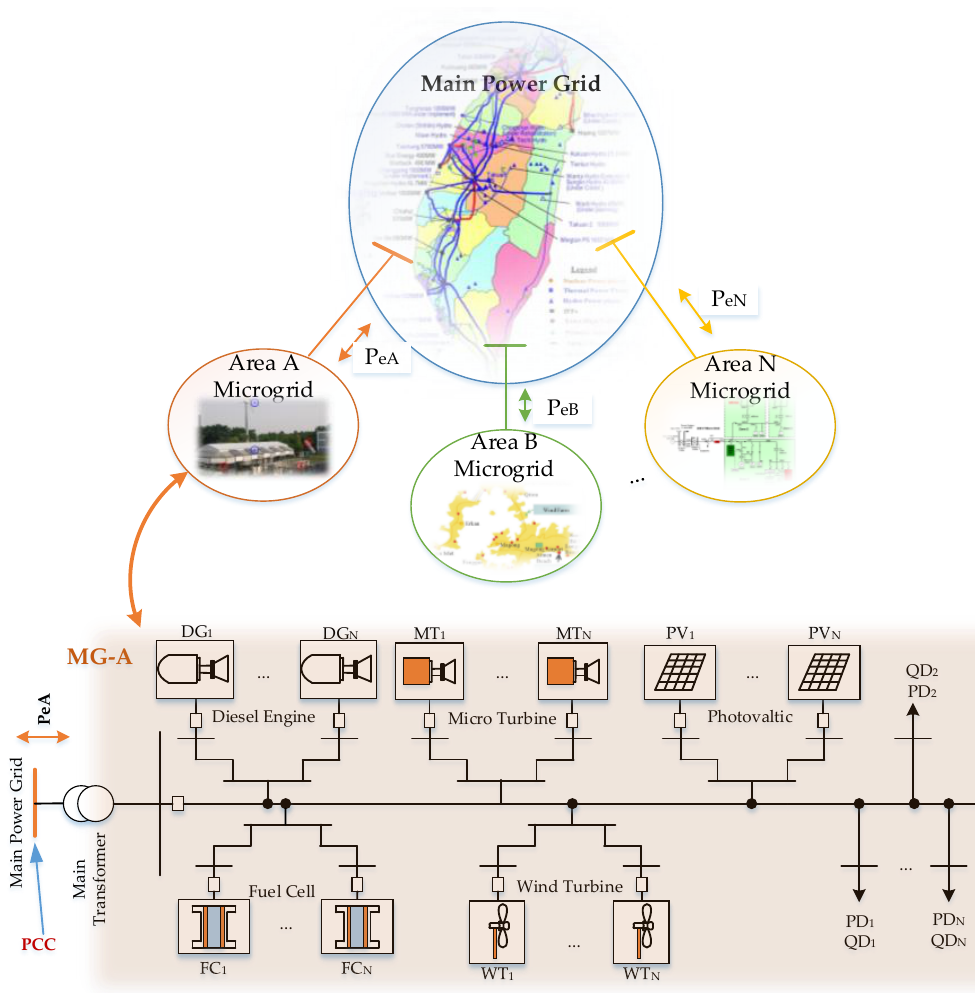
Figure 1. Structure of a power system considering N distribution substation-level MGs.